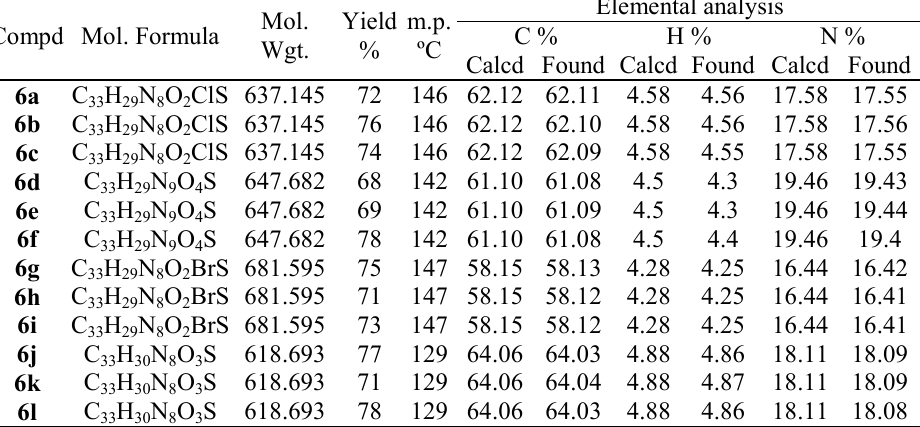
Table 1. Physical characterization data of synthesized compound